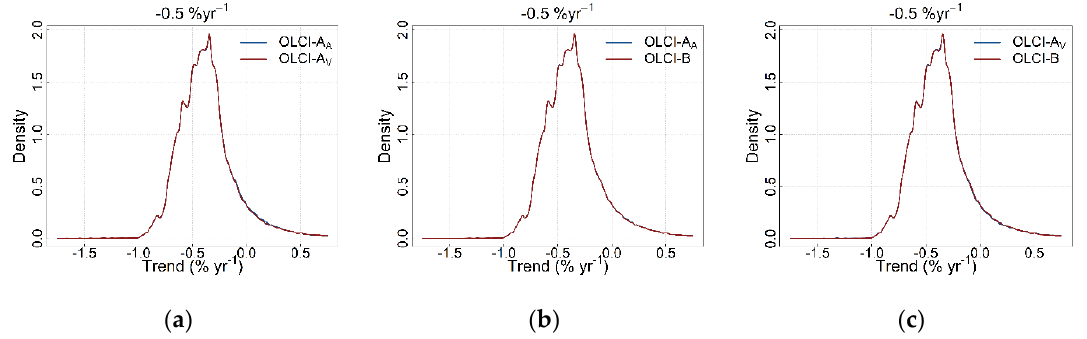
Figure 3. Histograms of −0.5 %·yr −1 input chl- a trends estimated in all 1° grid cells and all bootstraps. From ( a ) OLCI-A-Aligned and OLCI-A-Vicarious, ( b ) OLCI-A-Aligned and OLCI-B, and ( c ) OLCI-A-Vicarious and OLCI-B. All datasets show very similar distributions of chl- a trends. See Appendix A for corresponding histograms for all input trends.